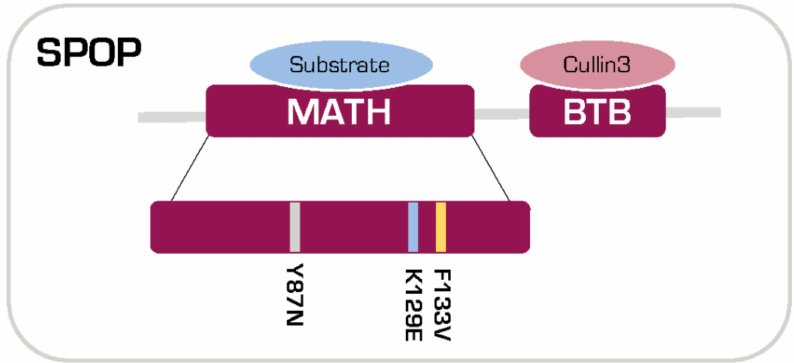
Figure 1. Illustration of SPOP domains and localization of prostate cancer-specific